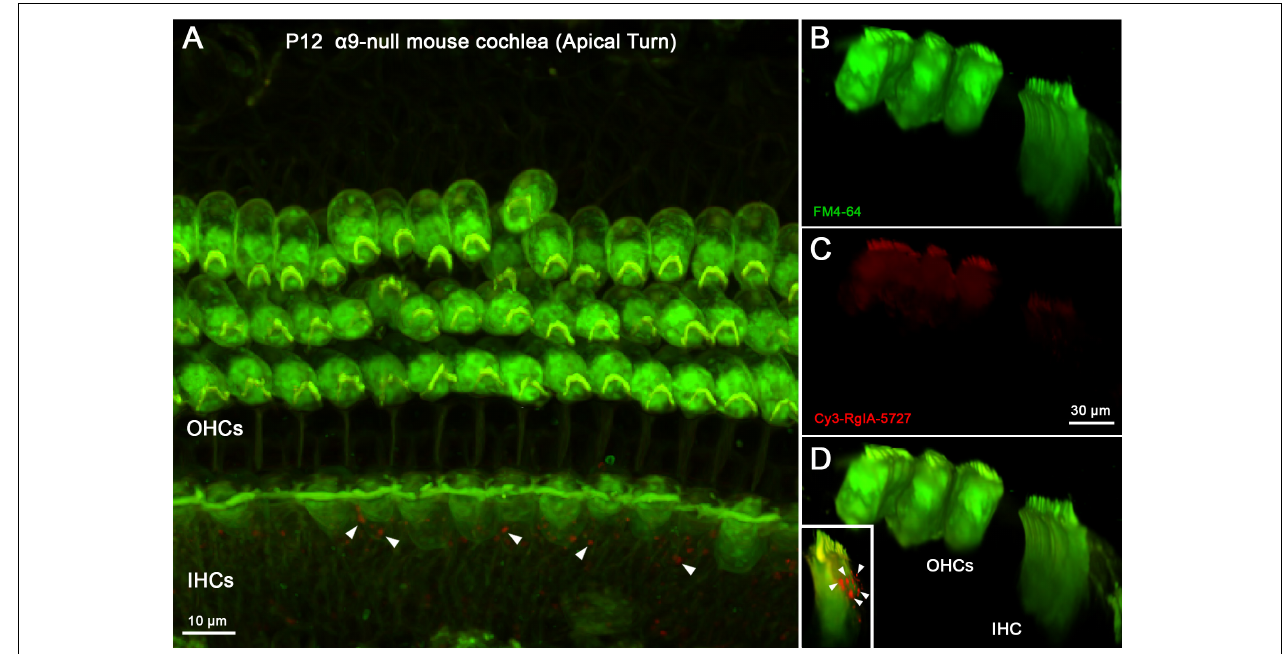
FIGURE 7 | Cy3-RgIA-5727 labeling in P12 α 9-null mouse cochlea. At this age efferent synapses occur on IHCs and OHCs, even in the absence of the α 9 subunit. (A) Maximum intensity projection (MIP) from the apical surface of the cochlea. (B) Optical yz-plane view of cochlea (MIP), three rows of OHCs on left, IHCs on right, green FM4-64 accumulation. (C) Cy3-RgIA-5727 in yz-plane view (MIP). (D) Merged view of FM4-64 and Cy3-RgIA-5727 (MIP). No Cy3 puncta are found in the synaptic regions of IHCs or OHCs. Cy3-RgIA-5727 puncta occurred medial to the IHCs in the greater epithelial ridge [inset and white arrowheads in panel (A) ]. Images exemplify results obtained from two cochleas from two knockout mice. See Supplementary Video 4 .